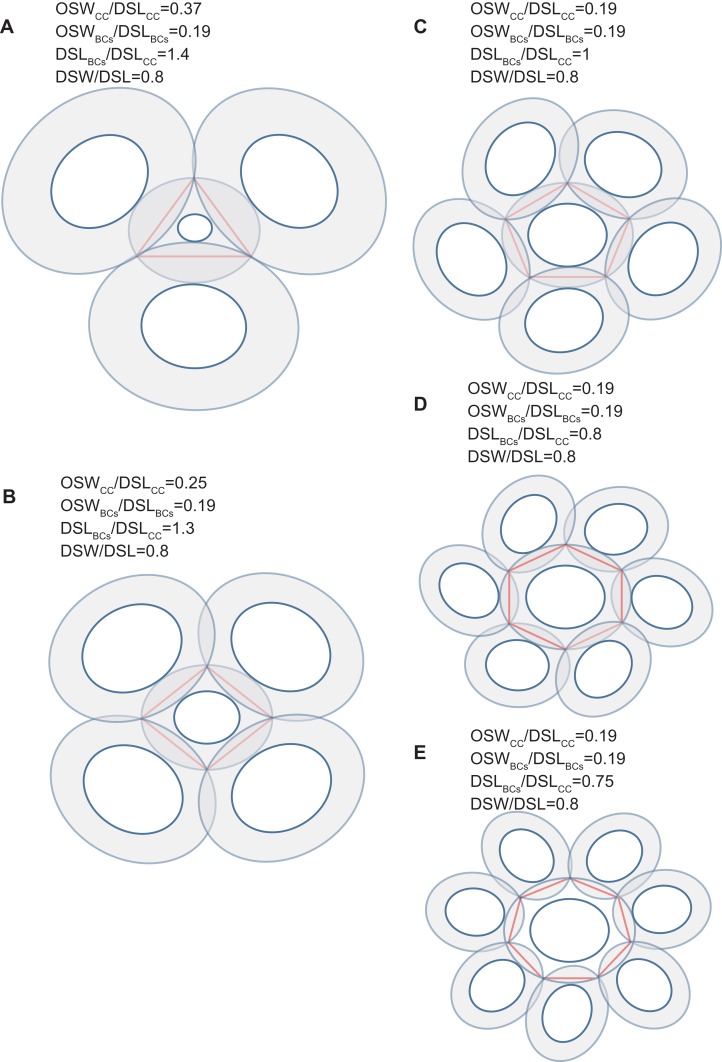
Simulation of interlocked coccoliths on a 2D plane.Central coccolith interlocked with three, four, five, six, and seven others (A–E). DSW/DSL of all coccoliths were set to an average value of 0.81. Values of OSWCC/DSLCC, OSWBCs/DSLBCs, and DSLBCs/DSLCC appear above the photos.